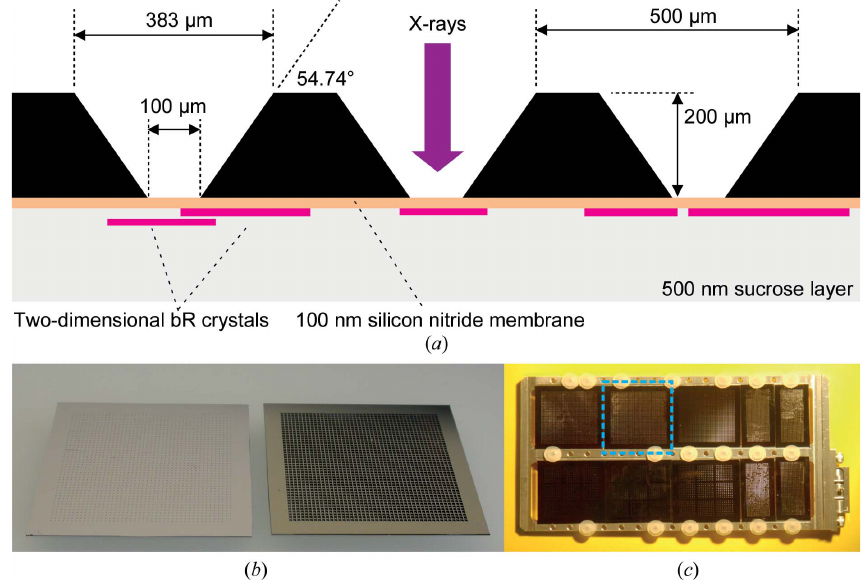
Figure 1 Sample support. ( a ) Sketch of the chip carrying the two-dimensional bR-D96N crystals (the membrane thickness is not to scale). ( b ) Picture showing the two faces of the chip, with the face encountered by the incoming X-ray beam on the right. ( c ) Picture of various chips fixed on the metallic frame that was mounted on the translation stages inside the CXI vacuum chamber for X-ray diffraction data collection. The chip carrying the two-dimensional bR-D96N crystals is delimited by the dashed blue